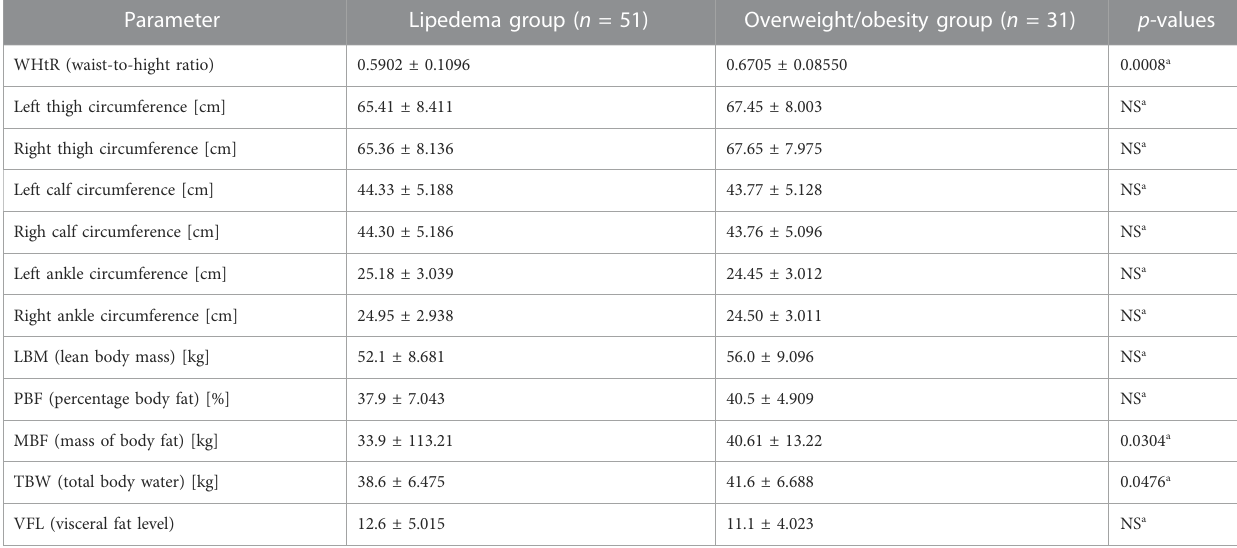
TABLE 2 ( Continued ) Clinical characteristics of subjects in groups with lipedema vs